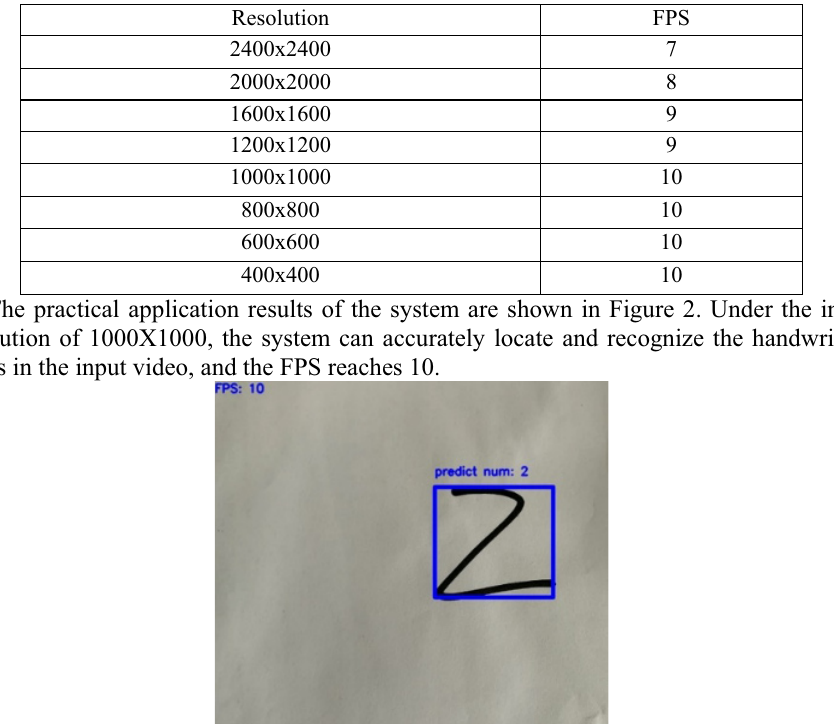
Table 3. FPS of input video with different resolutions.